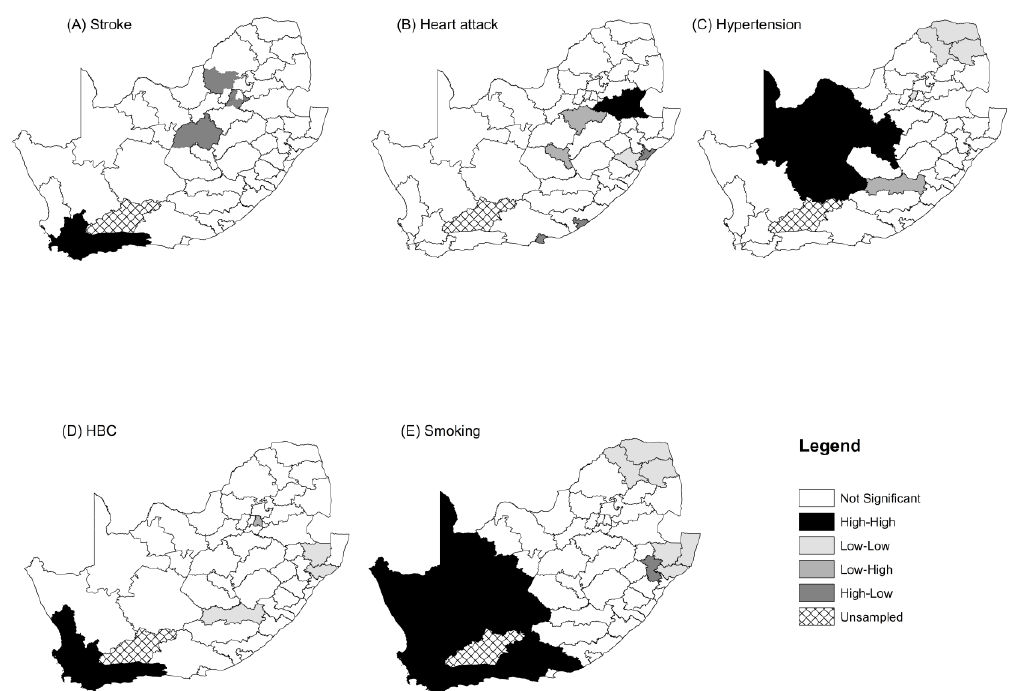
Figure A2. Univariate LISA cluster for the standardized incidence ratios of stroke, heart attack, hypertension, high blood cholesterol and Smoking.